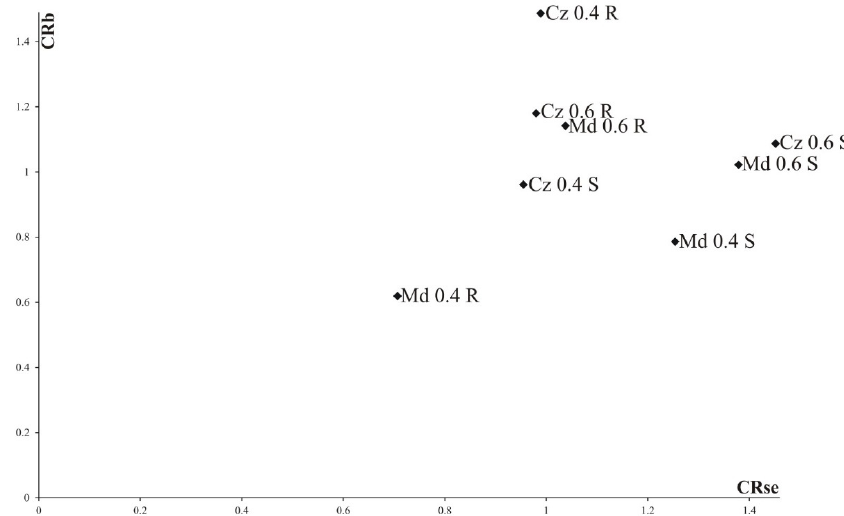
Figure 14. Relationships between relative biomass of plants (CRb) and the relative number of seeds (CRse) for the combinations of sites × winter wheat proportion in the mixture × cornflower biotypes, in 2019–2020. Legend: Cz—Czesławice, Md—Mydlniki (sites of experiments); R—cornflower with resistant biotype; S—susceptible biotype.